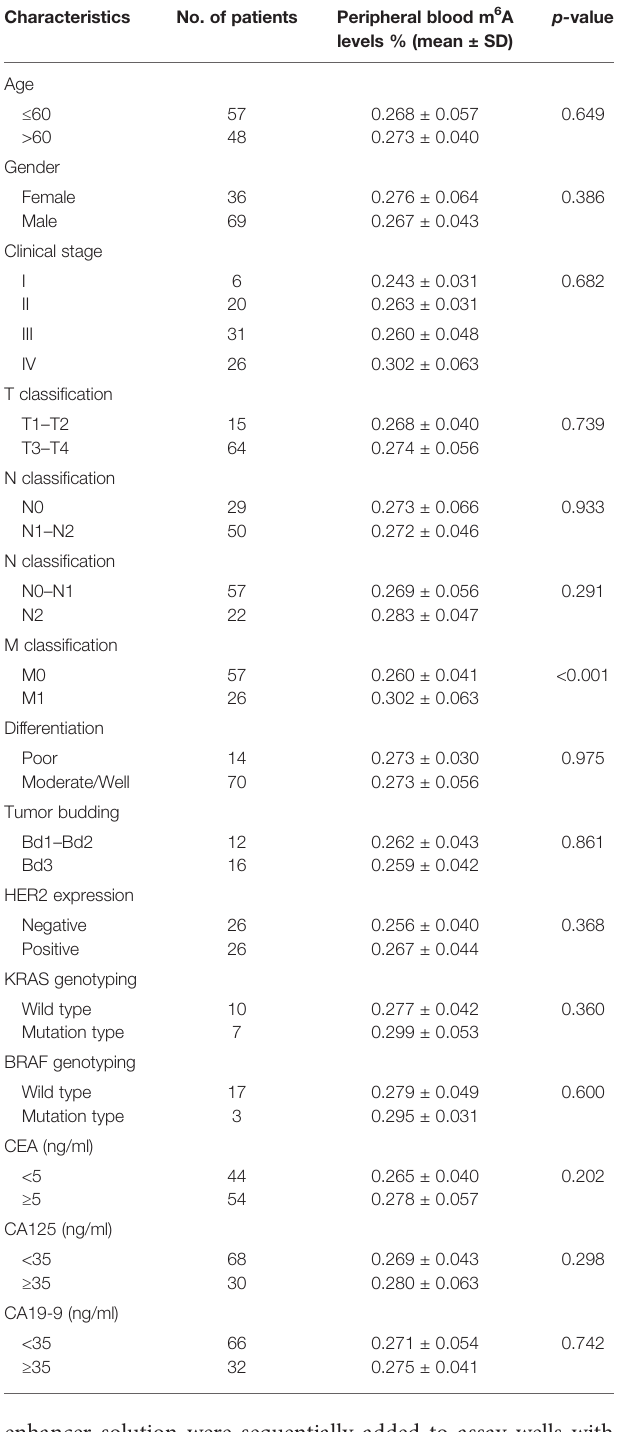
TABLE 1 | Correlation between the levels of m 6 A and clinicopathological characteristics in